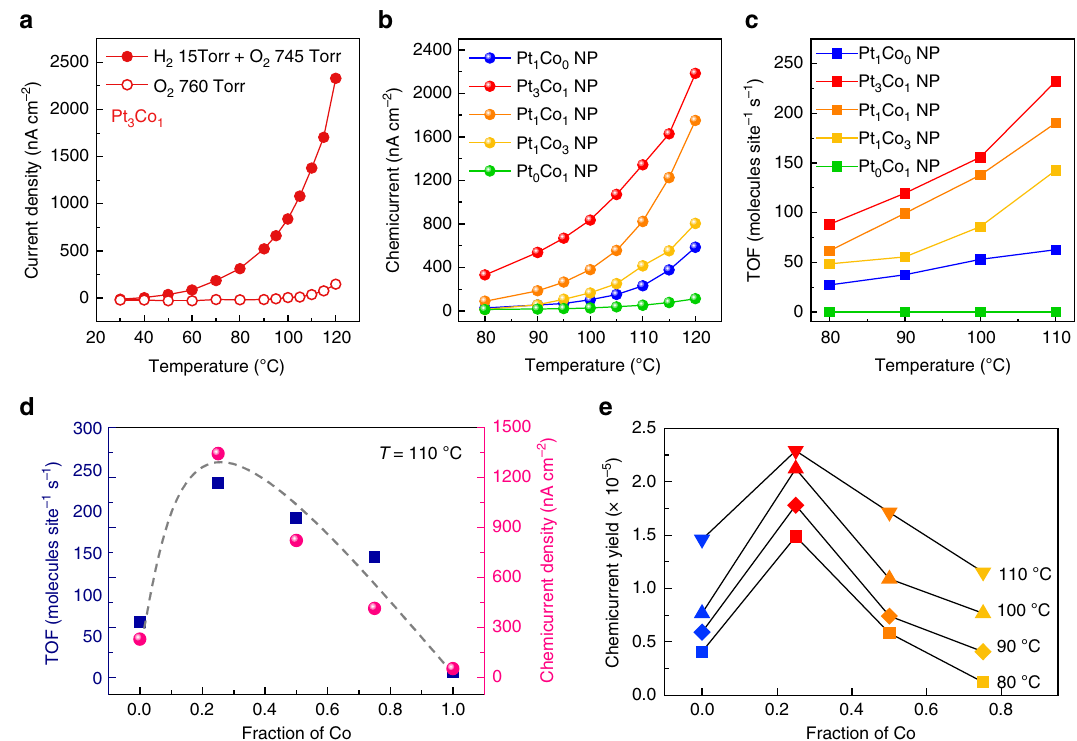
Fig. 3 Hot electron detection and catalytic activity on PtCo bimetallic NPs. a Temperature dependence of the current from the Au/TiO 2 nanodiodes with Pt 3 Co 1 NPs measured in the H 2 + O 2 gas mixture and in pure O 2 . b Chemicurrents associated with the H 2 oxidation reaction measured on the Au/TiO 2 nanodiodes at different temperatures with Pt x Co y NPs of different compositions; the data were normalized based on the total NP surface area. c Catalytic activity (i.e., TOF) for H 2 oxidation on a set of Pt x Co y NPs with different compositions. d Comparison of both the chemicurrent and TOF as a function of the composition of the PtCo bimetallic NPs at 110°C. e Plot of the chemicurrent yield as a function of the fraction of Co during H 2 oxidation at different temperatures